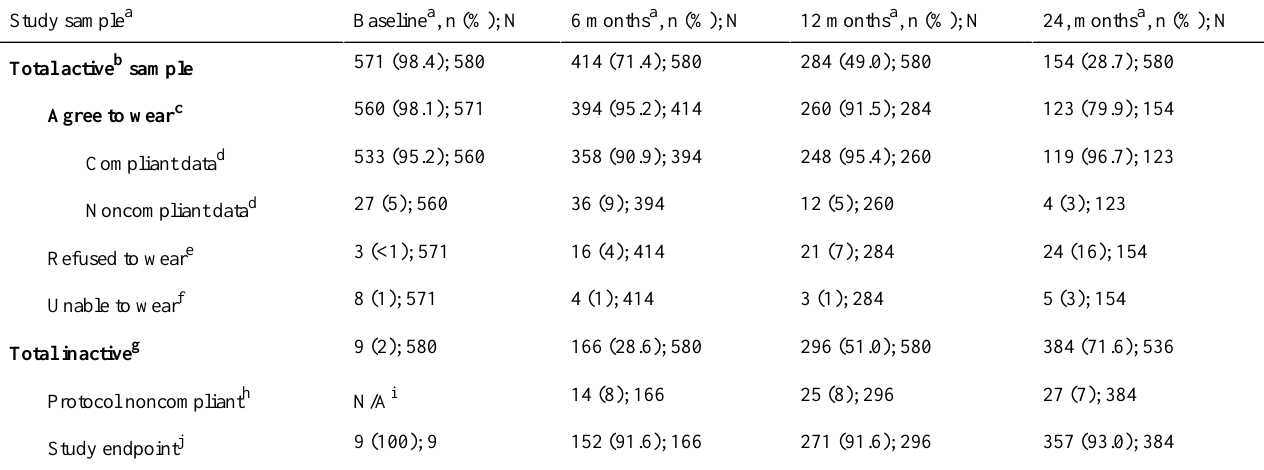
Table 1. Details of the accelerometer wear time compliance in 580 participants by time points on the Lifestyle Intervention for oVarian cancer Enhanced Survival accelerometer